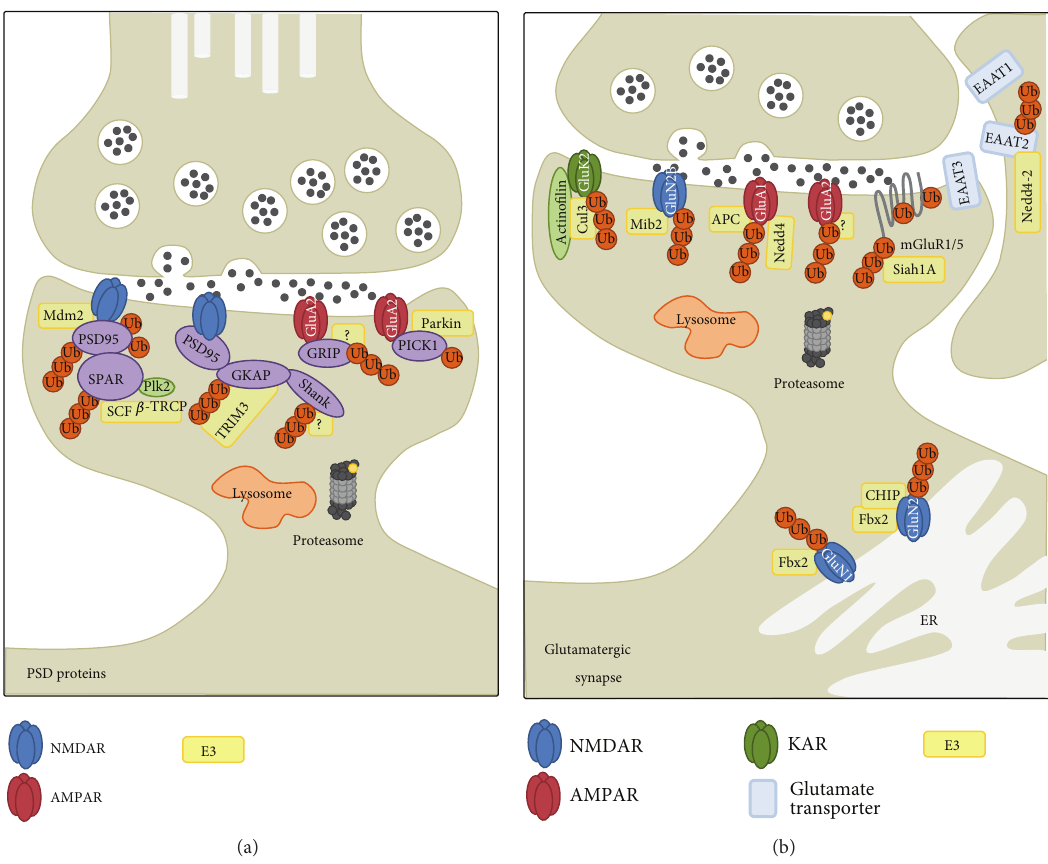
Figure 3: Postsynaptic ubiquitination. (a) Postsynaptic density proteins that undergo ubiquitination. PSD-95 is ubiquitinated by Mdm2. It is also monoubiquitinated at multiple sites and may be polyubiquitinated under specific circumstances. SPAR ubiquitination is reliant upon activity-dependent phosphorylation by Plk2 and regulated by the E3 complex SCF 𝛽 -TRCP . Stimulation of neuronal activity can also cause TRIM3-mediated ubiquitination of GKAP. GKAP forms a scaffolding complex with Shank and GRIP, which are also ubiquitinated although their specific E3 ligases remain unidentified. PICK1 ubiquitination is mediated by parkin, which monoubiquitinates PICK1 to potentially regulate its downstream effects. (b) Ubiquitinated proteins at glutamatergic synapses in the mammalian system. mGluR1 and mGluR5 can be ubiquitinated by the E3 ligase Siah1A, which binds to a site in the C-terminus of both mGluRs. In mGluR5, Siah1A has been shown to mediate ubiquitination at multiple lysine residues. In the case of KARs, actinofilin acts as a scaffold to bind GluK2-containing KARs to the E3 ligase Cul3. During NMDAR assembly in the ER, glycosylated GluN1 is ubiquitinated by Fbx2, which also can recognize and ubiquitinate GluN2A. Fbx2 can also couple with other cochaperones such as CHIP to regulate GluN2A ubiquitination. GluN2B on the other hand, is localized to the PSD and ubiquitinated by Mib2. The GluA1 subunit of AMPARs has recently been shown to be ubiquitinated by Nedd4-1 primarily at K868. Another member of the Nedd4 family, Nedd4-2, has been shown to ubiquitinate the glial glutamate transporter EAAT2. Another recently identified E3 ligase for GluA1 is APC. As of yet, no E3 ligase has been identified for